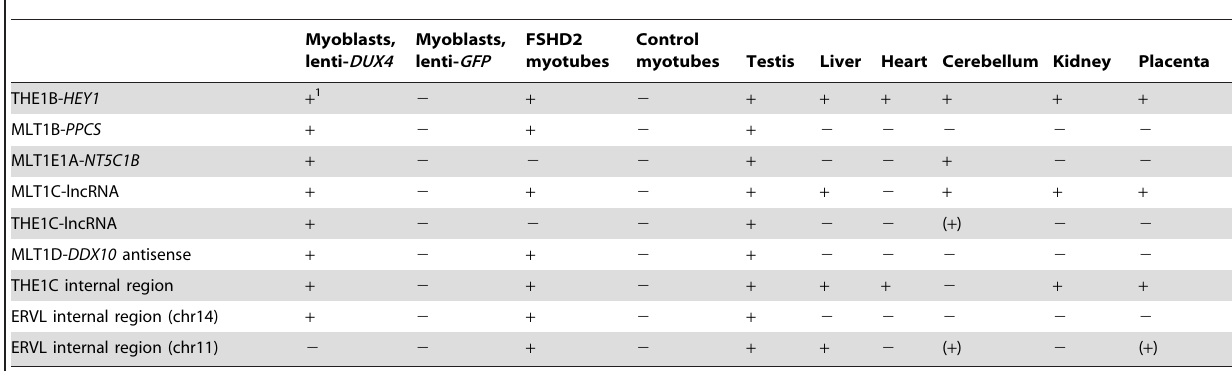
Table 2. RT-PCR confirms novel transcripts and shows their presence in testis and FHSD patient cells.